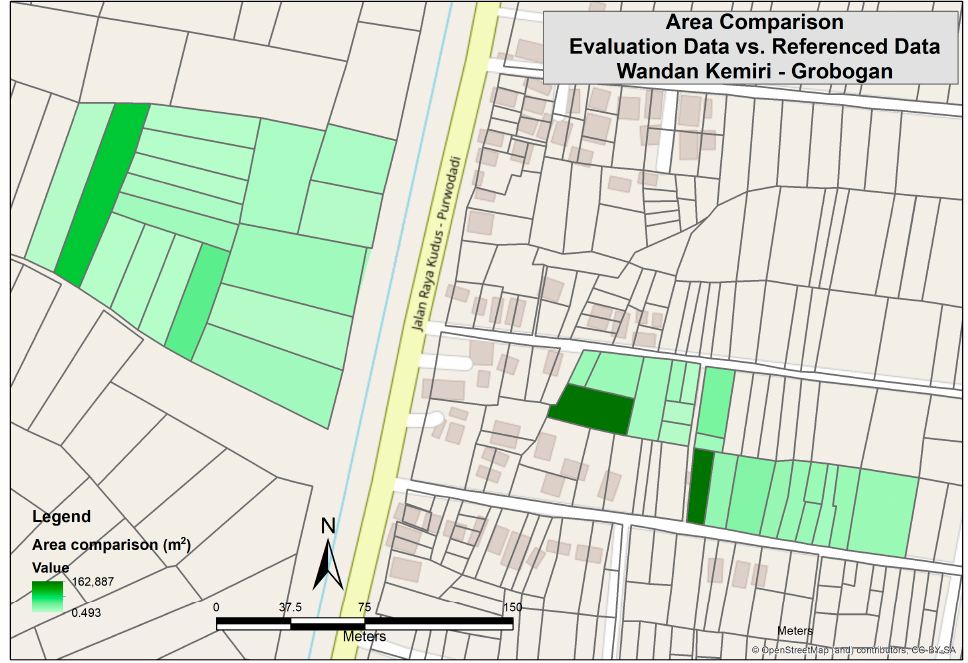
Figure A5. Map of area comparisons between the evaluation and reference data in Grobogan.